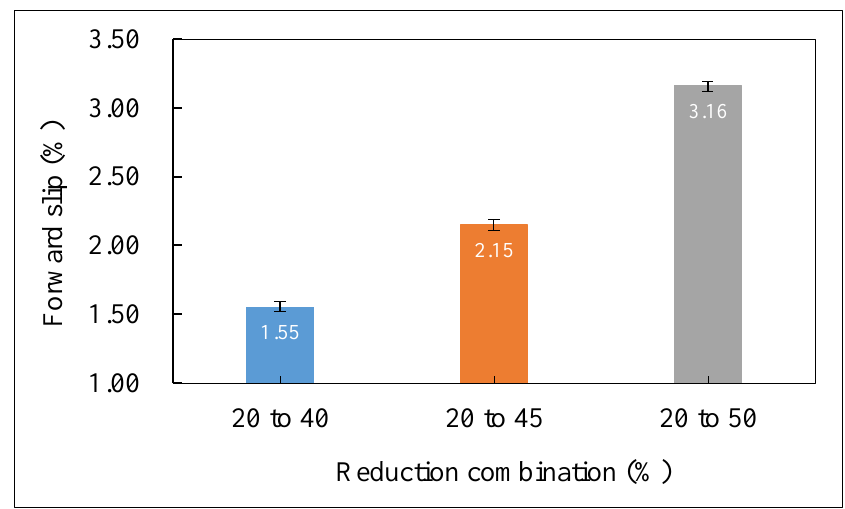
Figure 5. Forward slip versus reduction for the rolling phase with thinner thickness.